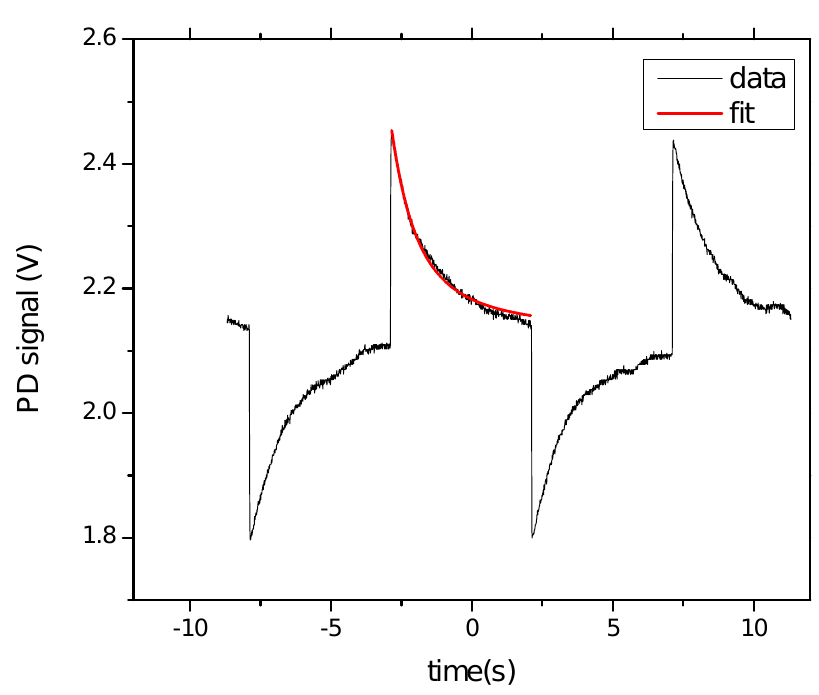
Figure 2. A typical experimental result obtained with our method. Sample Zn:LN, beam power 175 mW. The red line is a fit to Equation (6).